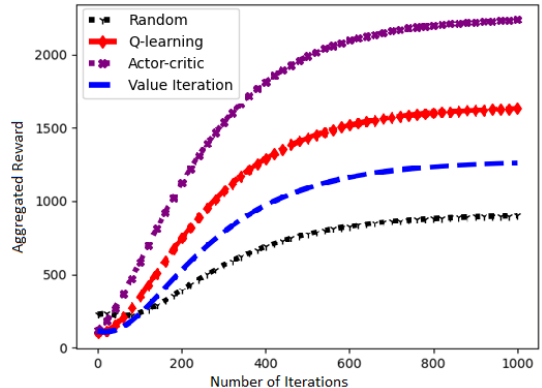
Figure 11. Learn curves of the RL